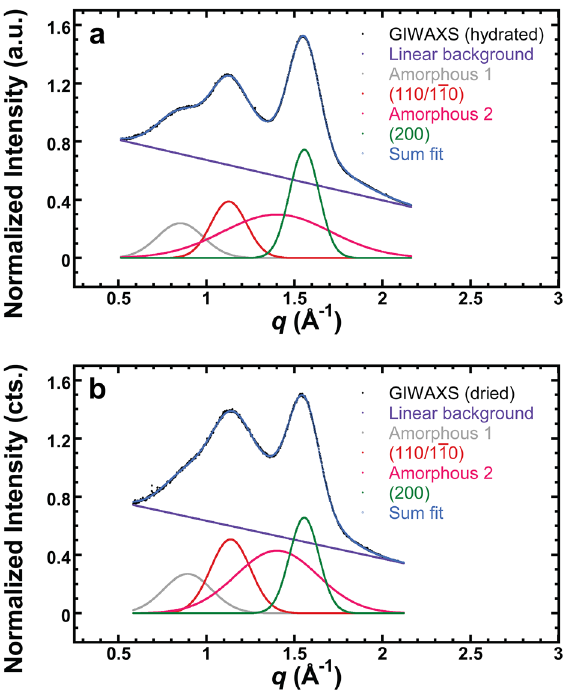
Figure 3. Examples of peak deconvolutions of the out-of-plane profiles from GIWAXS of ( a ) hydrated and ( b ) dried onion epidermal wall. GIWAXS data is shown in black (GIWAXS out-of-plane profile), and components that make up a fit to the data (Sum Fit) are also shown. Amorphous 1 and Amorphous 2 primarily arise from pectin and cuticle, respectively. The ( 110 / 110 ) and (200) reflections are from crystalline cellulose for the Iβ allomorph.